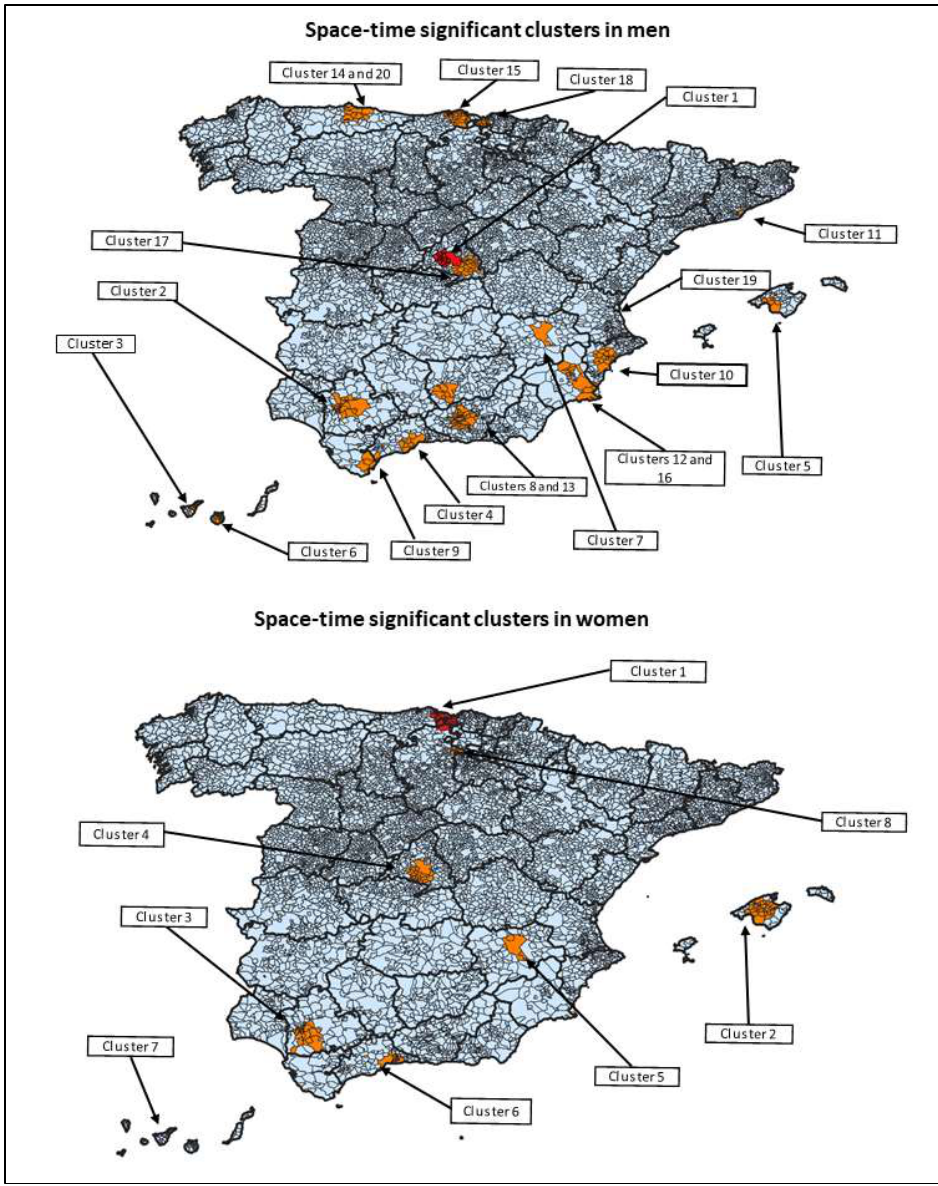
Figure 5. Map of municipalities involved in the space–time significant clusters of hepatitis A. In the female population, eight statistically significant clusters were detected (Figure 5, Table 2). The most likely cluster was located in an area composed of 31 municipalities of three different autonomous regions in the north of the country; 7/31 municipalities belonged to the same large urban Area, whereas 22/31 municipalities were classified as non-urban. The cluster was constituted by 13 observed cases from 2 June 2017 to 23 June 2017, with 0.10 expected cases. Similar to the male population, most clusters were also detected in other large urban areas, such as cluster two, cluster three, cluster four, cluster six and cluster seven; cluster eight included only municipalities classified as non-urban or small urban areas (eight and one municipalities, respectively). All clusters were detected throughout